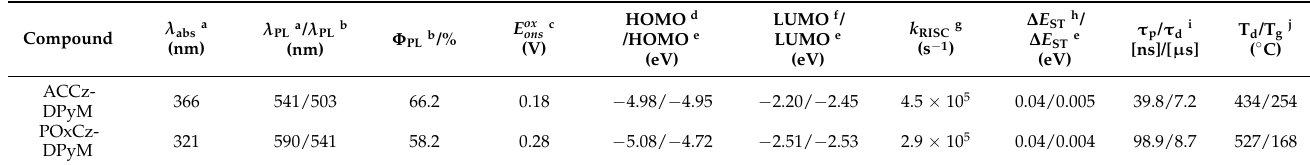
Table 1. The test data of ACCz-DPyM and POxCz-DPyM.